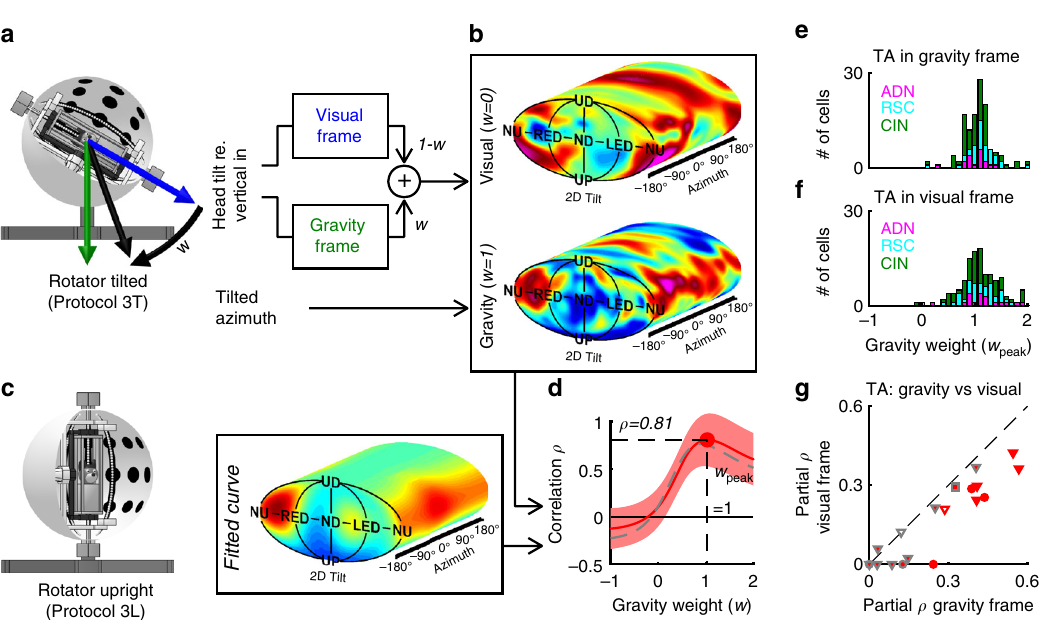
Fig. 6 Tilt tuning is anchored to gravity. a , b Rationale of the analysis and 3D tuning curve of an example cell when tilt is expressed relative to visually referenced vertical ( b , upper tuning curve) or gravitational vertical ( b , lower tuning curve). c Reference curve computed with the rotator upright. d Red: Coef fi cient of correlation between the tuning curves in a and the reference in b , as a function of the weight w , assuming TA is referenced to gravity. The red band indicates 95% con fi dence interval. Broken gray line: same correlation, computed assuming that TA is anchored to vision. e , f Gravity weight at which the correlation is maximal for all tilt-tuned cells where w peak is signi fi cantly higher than 0, computed when TA is referenced to gravity ( e ) or vision ( f ). g Comparison of the partial correlation (with the effect of gravity removed) of azimuth-tuned cells, assuming that TA is anchored to a gravity or visually referenced frame. Open/ fi lled symbols: azimuth-only and conjunctive cells. Red/gray: cells where the difference between the two frames is signi fi cant or not. Source data are provided as a Source Data fi